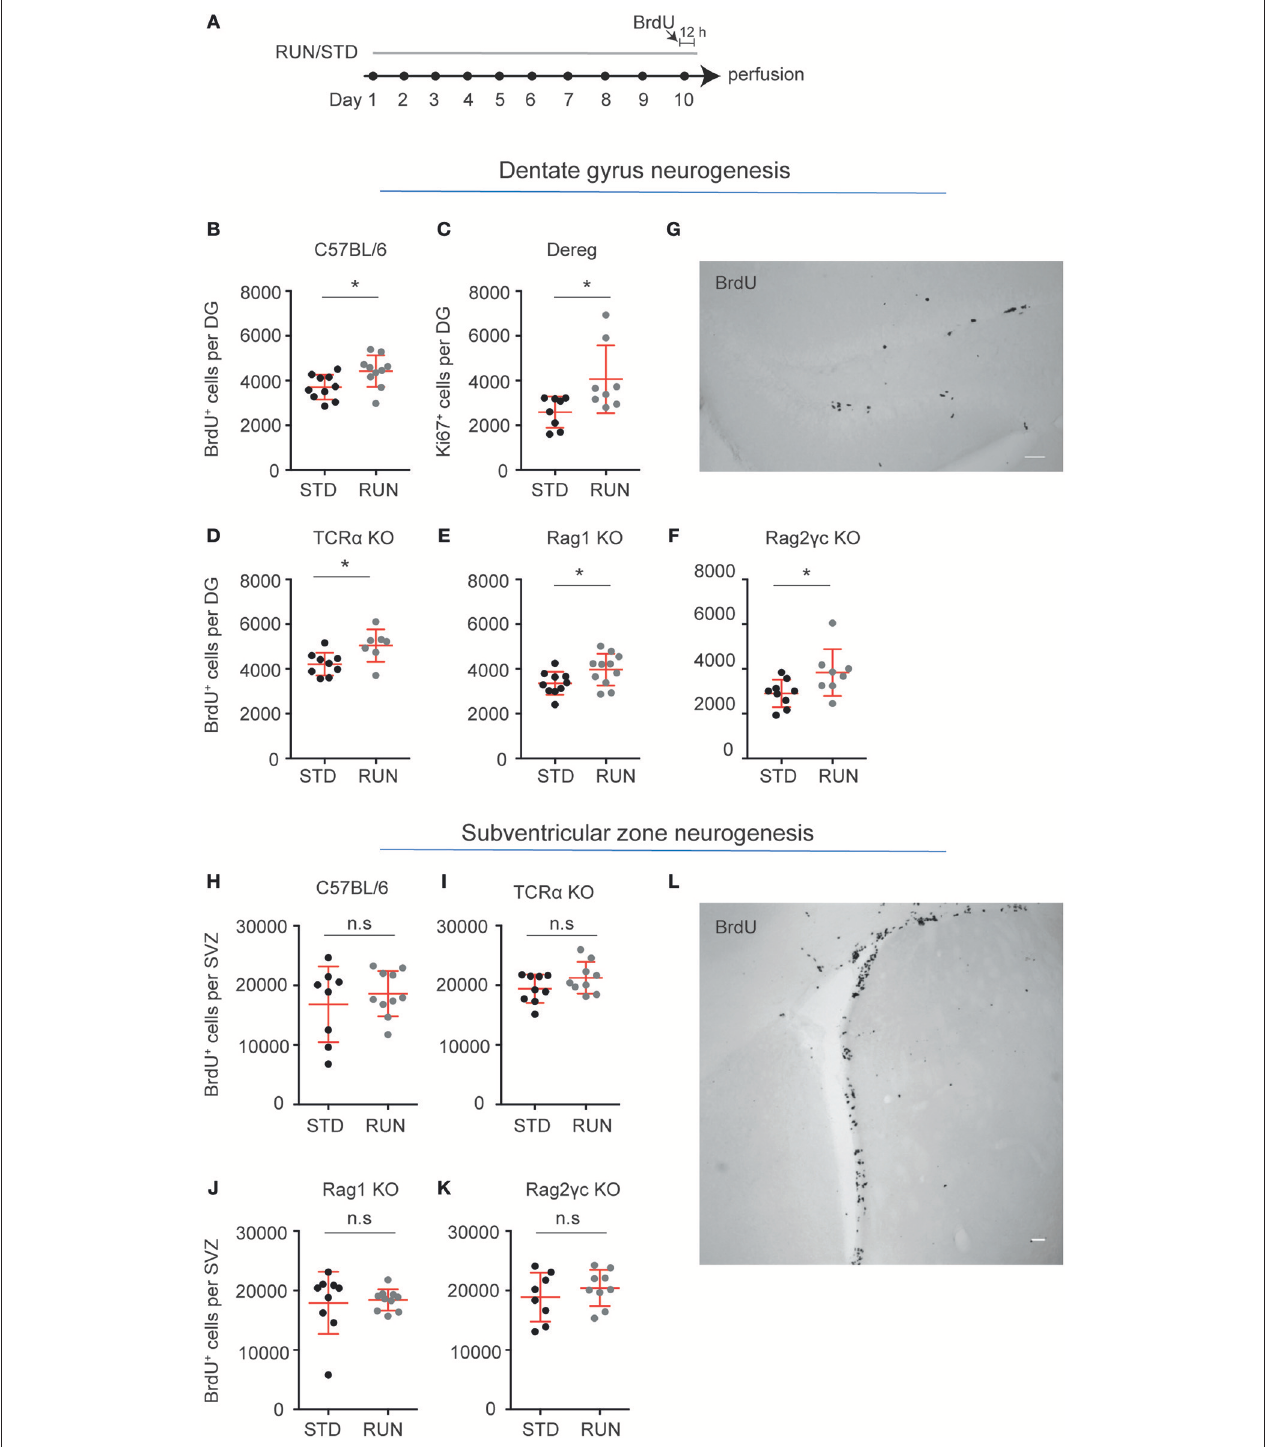
FIGURE 2 | Lymphocytes are not required for the exercise-induced increase in hippocampal precursor proliferation . (A) Experimental design. Following exercise, a significant increase in the number of proliferating precursor cells was observed within the DG of C57BL/6 (B) , Dereg (C) , TCR α − / − (D) , Rag1 − / − (E), and Rag2 − / − γ c − / − (F) mice. (G) Representative image of BrdU staining in the DG of Rag2 − / − γ c − / − mice. No change in baseline proliferation, or a response to physical exercise was observed in the other neurogenic niche, the SVZ, in C57BL/6 (H) , TCR α − / − (I) , Rag1 − / − (J), and Rag2 − / − c γ − / − (K) mice. (L) Representative image of BrdU staining in the DG of Rag2 − / − c γ − / − mice. Symbols and horizontal lines indicate individual mice and mean values ± SEM, respectively. The level of significance was determined using a two-tailed Student’s t -test. * p < 0.05, n.s = not significant. Scale bars in (F,K) are 50 µ m.